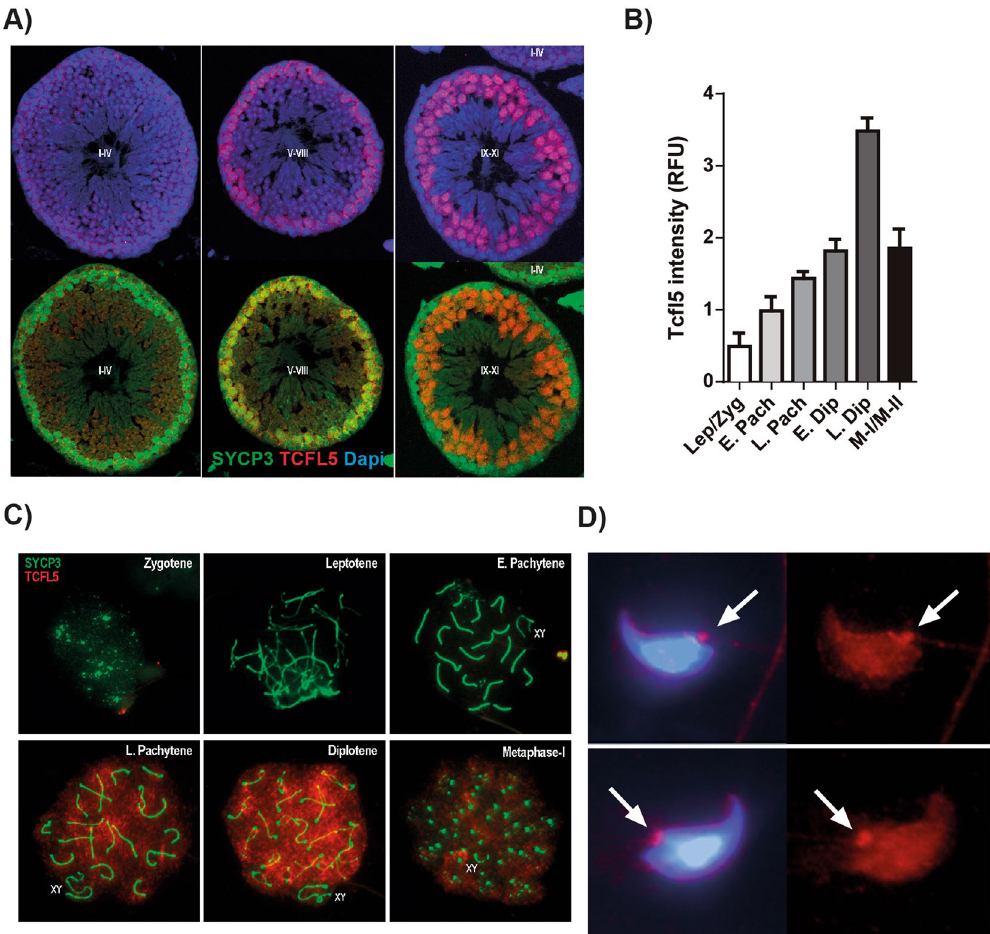
Figure 1. TCFL5 distribution during meiosis-I. ( A ) Immunohistofluorescence of seminiferous tubules stages I–IV, V–VIII and IX–X in TCFL5 +/+ mice. TCFL5 (red), SYCP3 (green) and nucleus (Dapi, Blue) were detected. TCFL5 is expressed in spermatocytes but neither spermatogonia nor spermatids. ( B ) Quantification of TCFL5 expression in spread primary spermatocytes. TCFL5 is mostly expressed from late pachytene to diplotene. ( C ) Representative immunofluorescence of spread primary spermatocytes in TCFL5 +/+ mice. SYCP3 (green), TCFL5 (red) and nucleus (Dapi, Blue) were detected. D) Representative immunofluorescence of spermatids. TCFL5 (red) and nucleus (Dapi, Blue) were